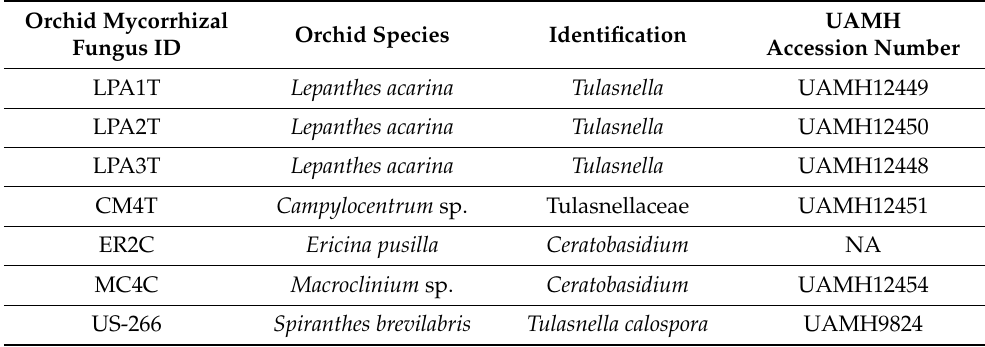
Table 1. Putative orchid mycorrhizal fungi, isolated from different orchid species from Ecuador and the United States, used as symbiotic treatments to germinate sterile seeds of E. geminiflorum .